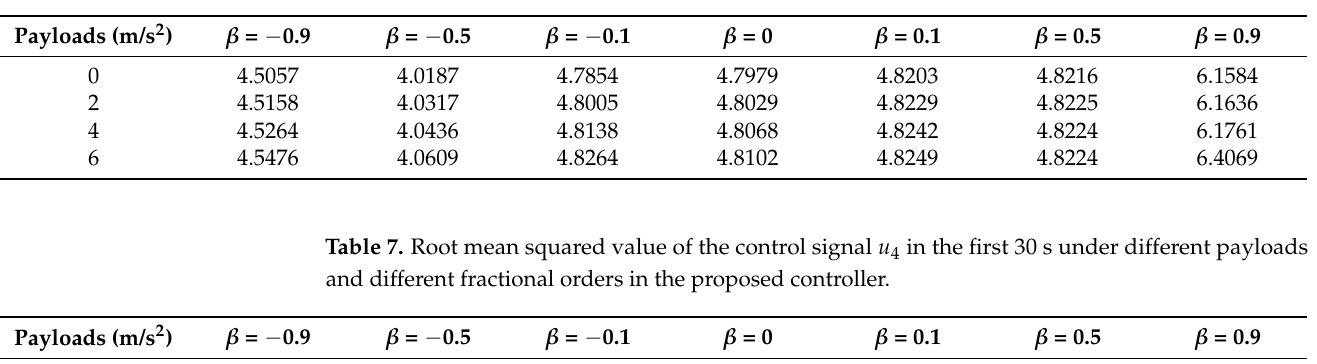
Table 6. Root mean squared value of the control signal u 3 in the first 30 s under different payloads and different fractional orders in the proposed controller.